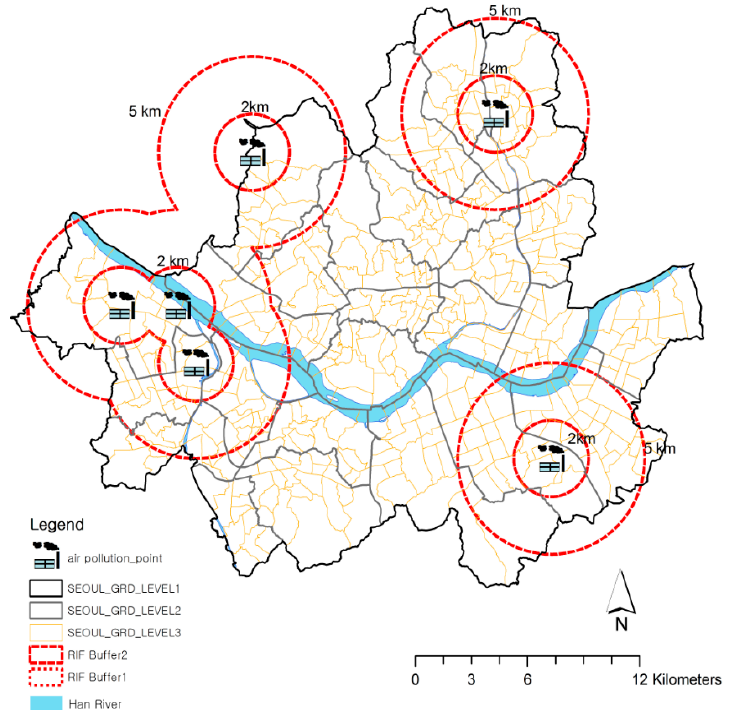
Figure 4. Buffer Zones from Incineration Facilities, Seoul. Figure 4. Bu ff er Zones from Incineration Facilities,